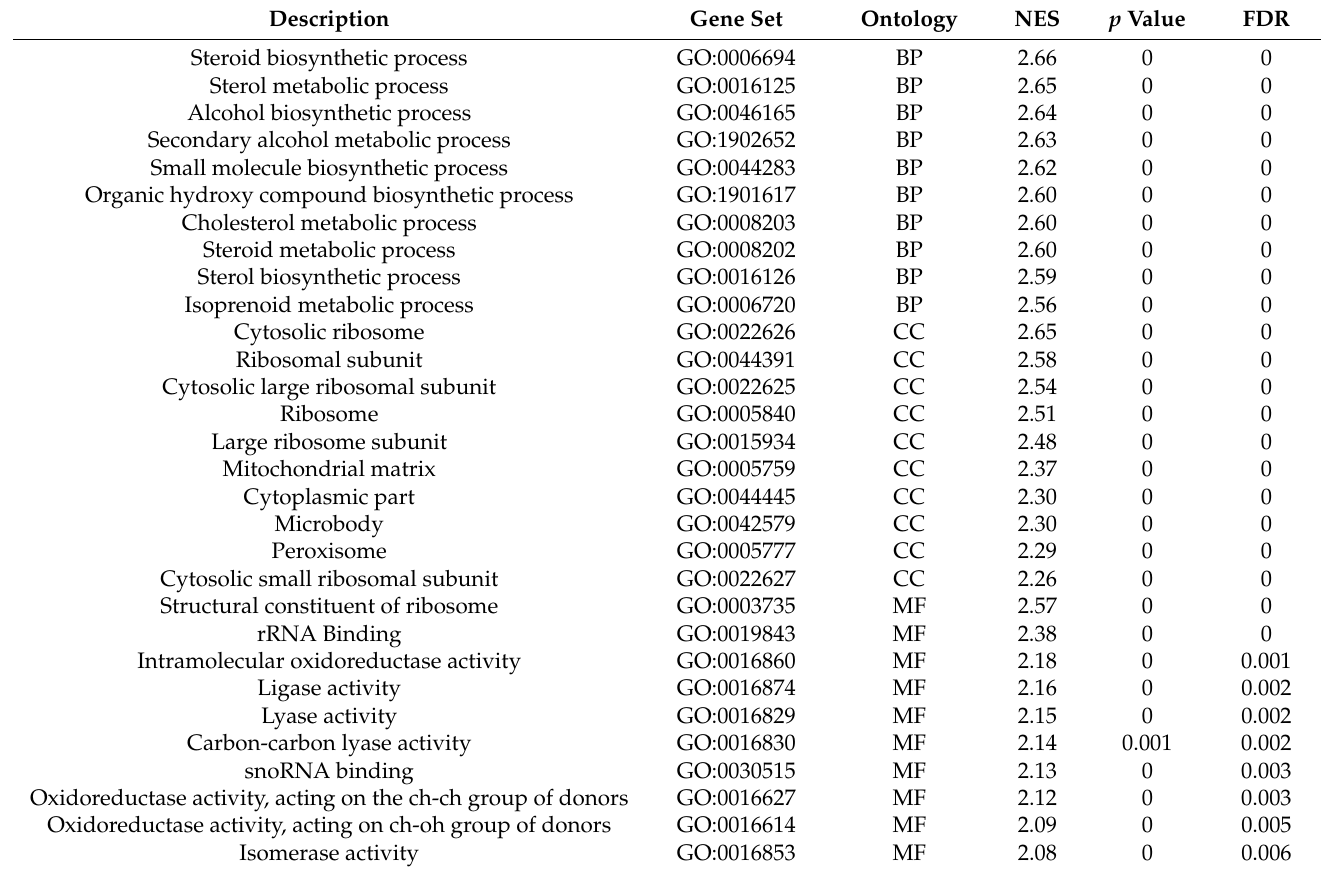
Table 1. Top positive enrichment GO terms (BP, CC, MF) of differentially expressed genes using GSEA 1